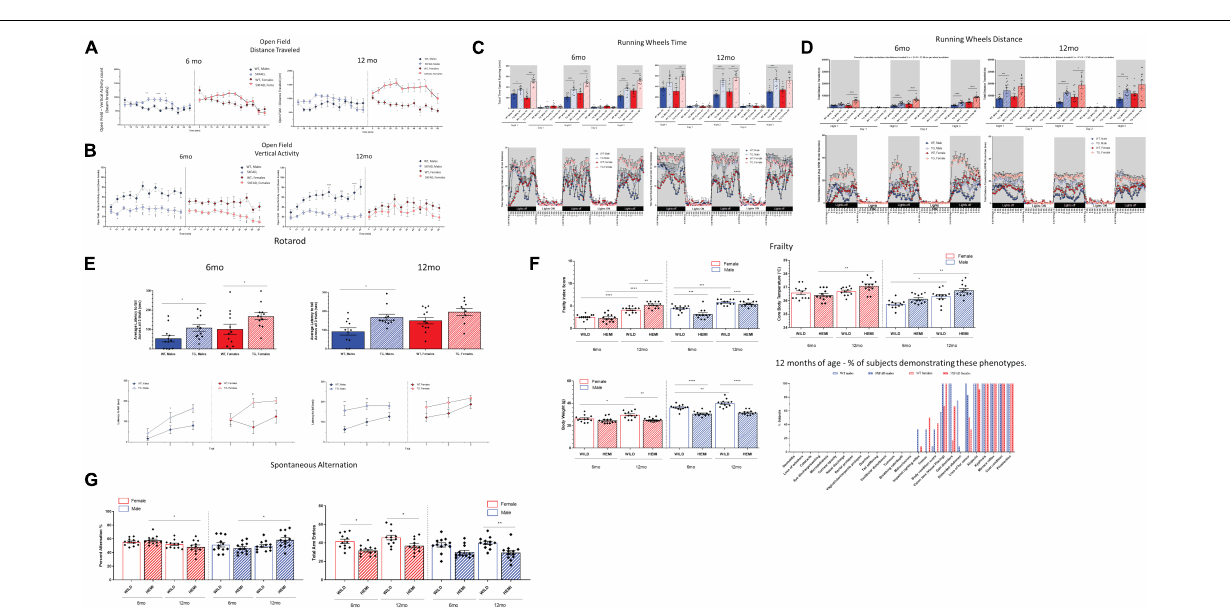
FIGURE 2 | Functional assessment reveals hyperactivity associated with changes in frailty score in 5XFAD mice. Hyperactivity was observed in 5XFAD mice compared with controls was determined using open field and running wheels (A–D) . There were increases in distance traveled, vertical and horizonal activity and reductions in resting time. In the rotarod test (E) , both male and female 5XFAD mice maintained their balance for a greater period of time than the age-and sex-matched WT controls. Male and female 5XFAD mice and controls demonstrated aging-dependent increases in frailty scores from 6 months to 12 months of age (F) . 5XFAD male or female mice did not demonstrate deficits in percent alternation relative to age-and sex-matched controls at either 6 or 12 months of age (G)